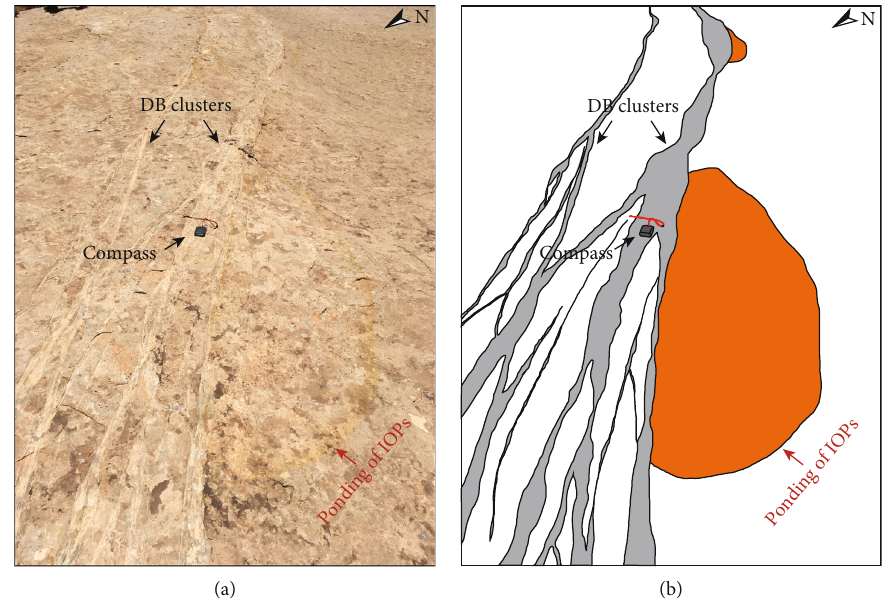
Figure 5: (a) Field photo and (b) sketch of deformation band cluster causing ponding of iron oxide precipitates (IOPs) found in Arches National Park, Utah,